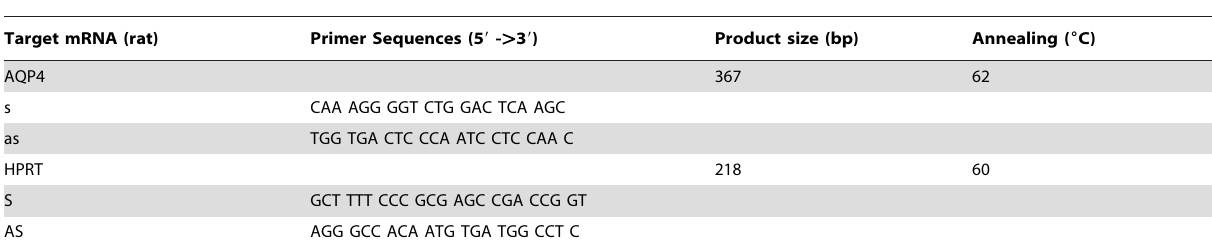
Table 1. List of primer sequences used in this study.